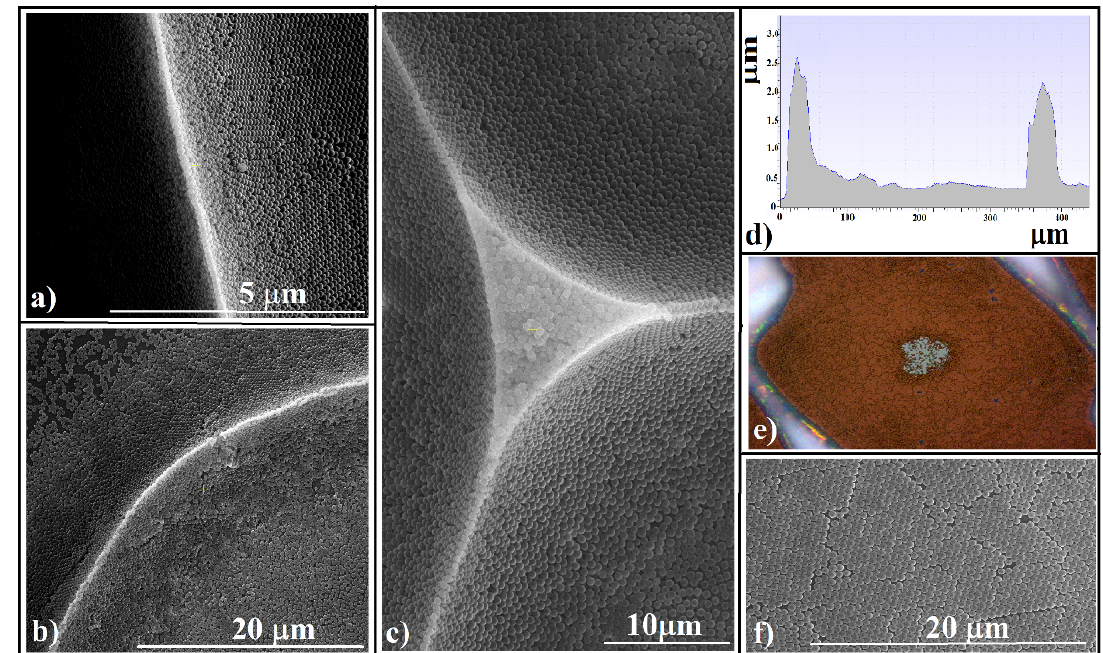
Figure 3. SEM images of: ( a ) Straight triangular prism; ( b ) curved triangular prism; ( c ) knot; ( d ) profile of a unit cell; ( e ) reflection optical microscopy of a unit cell; ( f ) SEM image of PS single layer from the inside of unit cell. Table 1. Quantification of the order quality of self-assembly of sub-micron